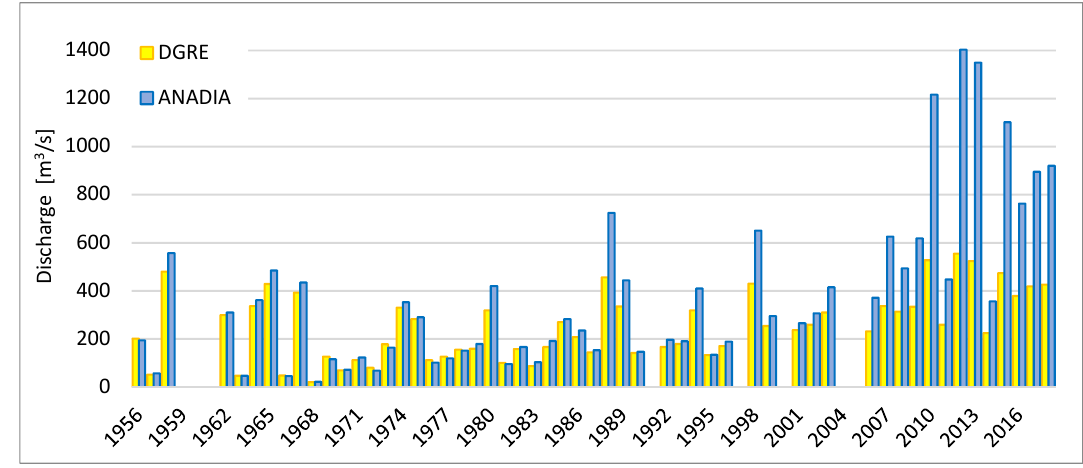
Figure 6. Comparison between the DGRE (yellow bars) and ANADIA (blue bars) time series of annual maximum discharge.